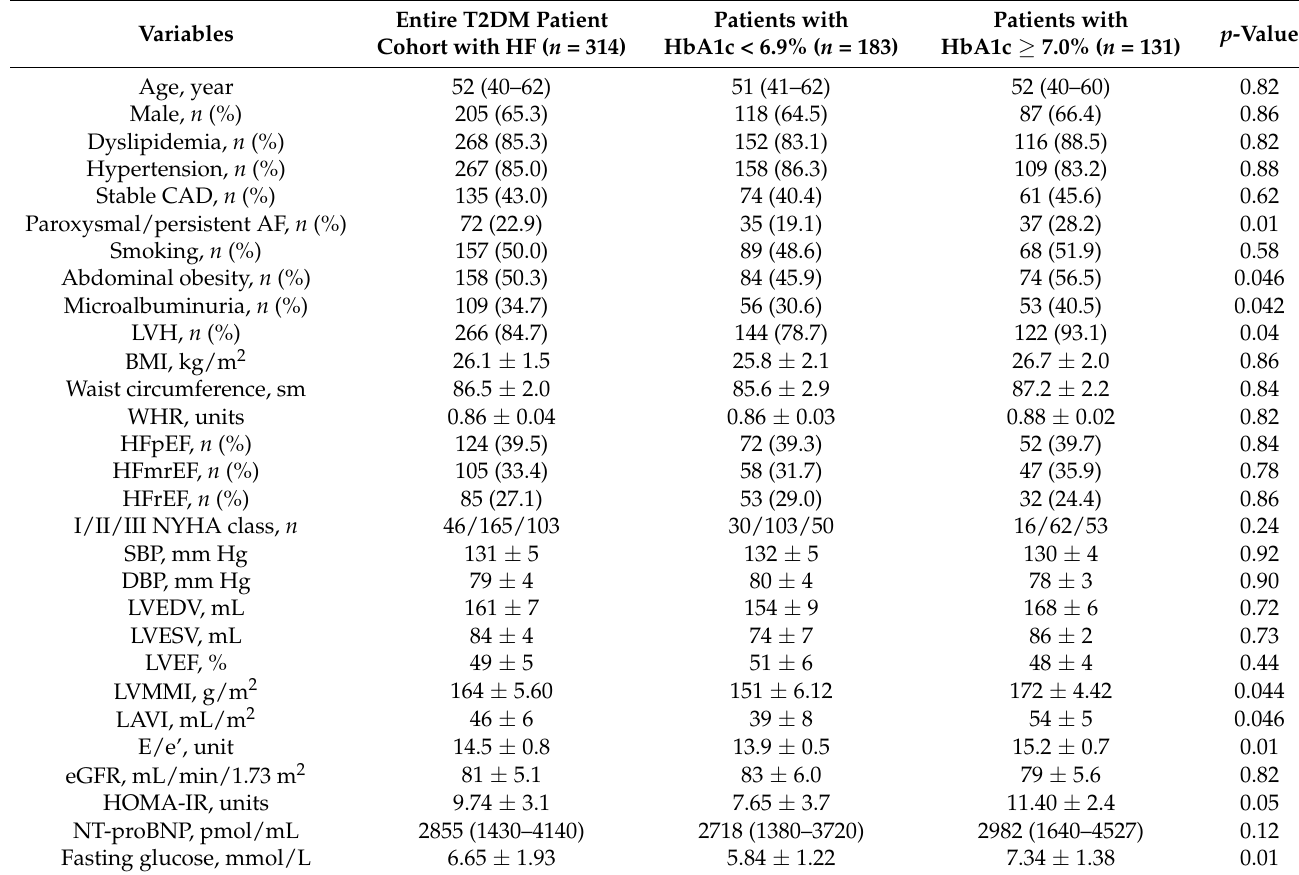
Table 1. Basic demographic, clinical, and hemodynamic characteristics, biochemistry biomarkers and concomitant medications of patients in the study